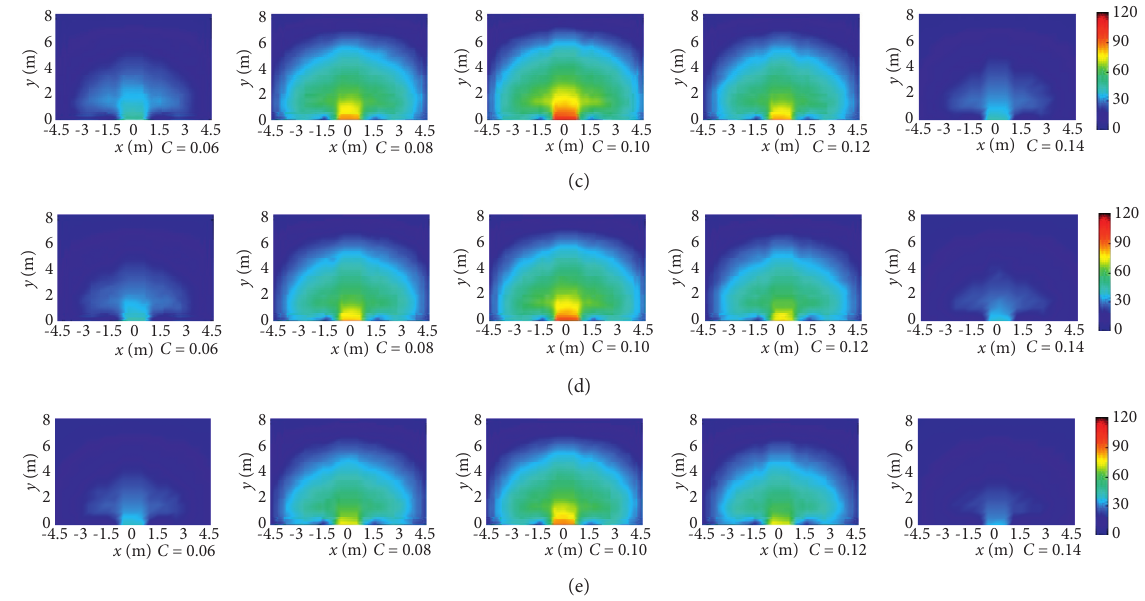
Figure 12: Peak pressure nephograms under different working conditions: Scheme 2 (kPa). (a) (T) � − 60 ° C. (b) (T) � − 30 ° C. (c) (T)